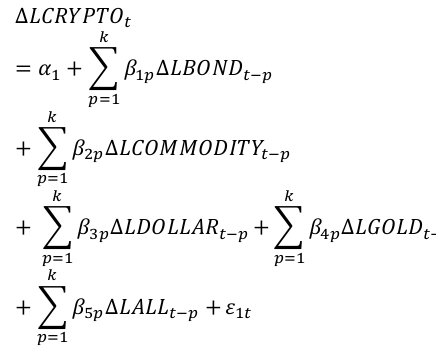
Table 6: Block Granger Causality Analysis